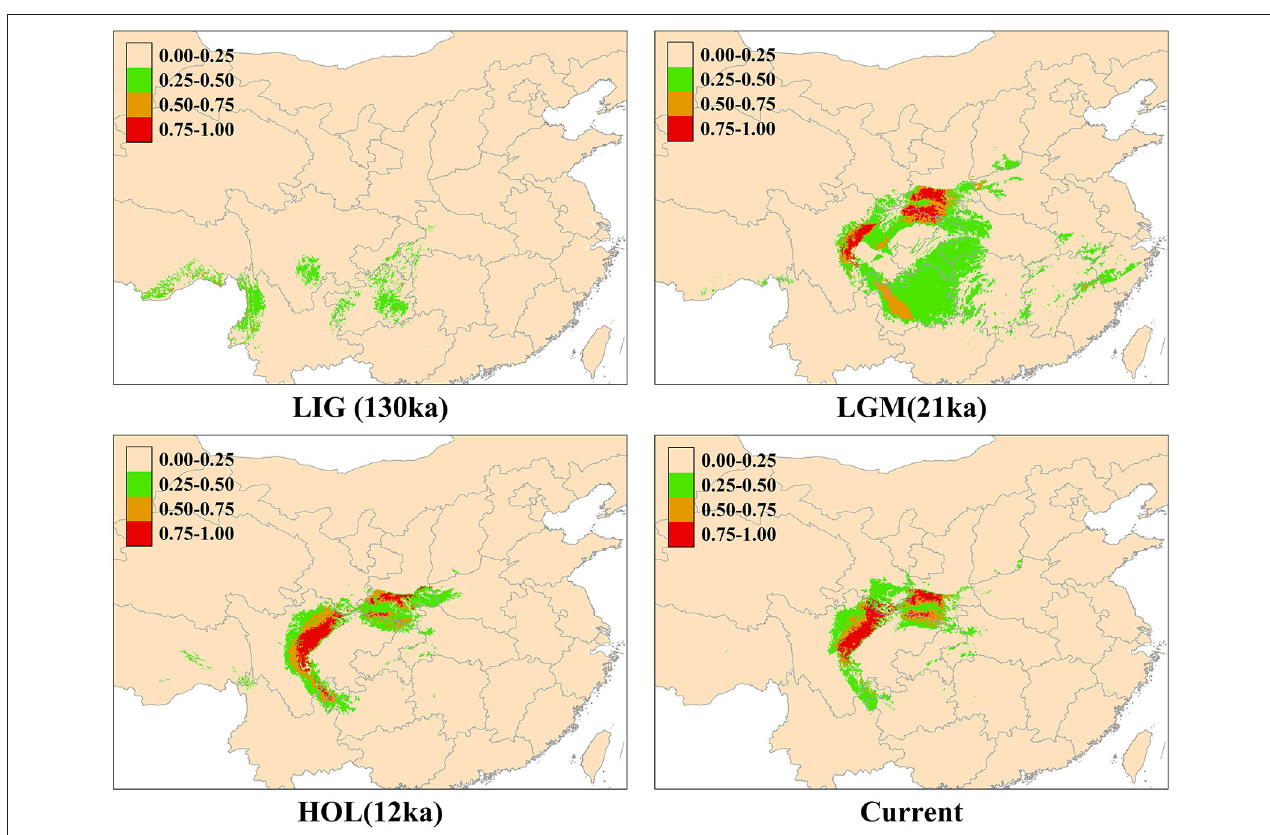
FIGURE 4 | Predicted past and current distributions of Rhinopithecus roxellana based on ecological niche modeling using MAXENT : the current, the Holocene (HOL; 12 ka–current), the last glacial maximum (LGM; 18–21 ka), and the last interglacial period (LIG; 120–140 ka).